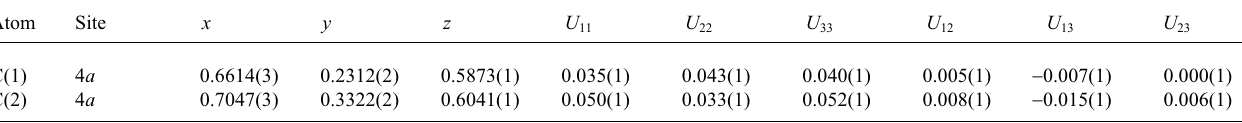
Table 3. Atomic coordinates and displacement parameters (in Å 2